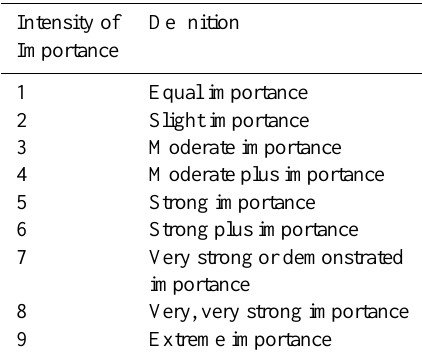
Table 1. The fundamental scale of absolute numbers in AHP (Saaty,